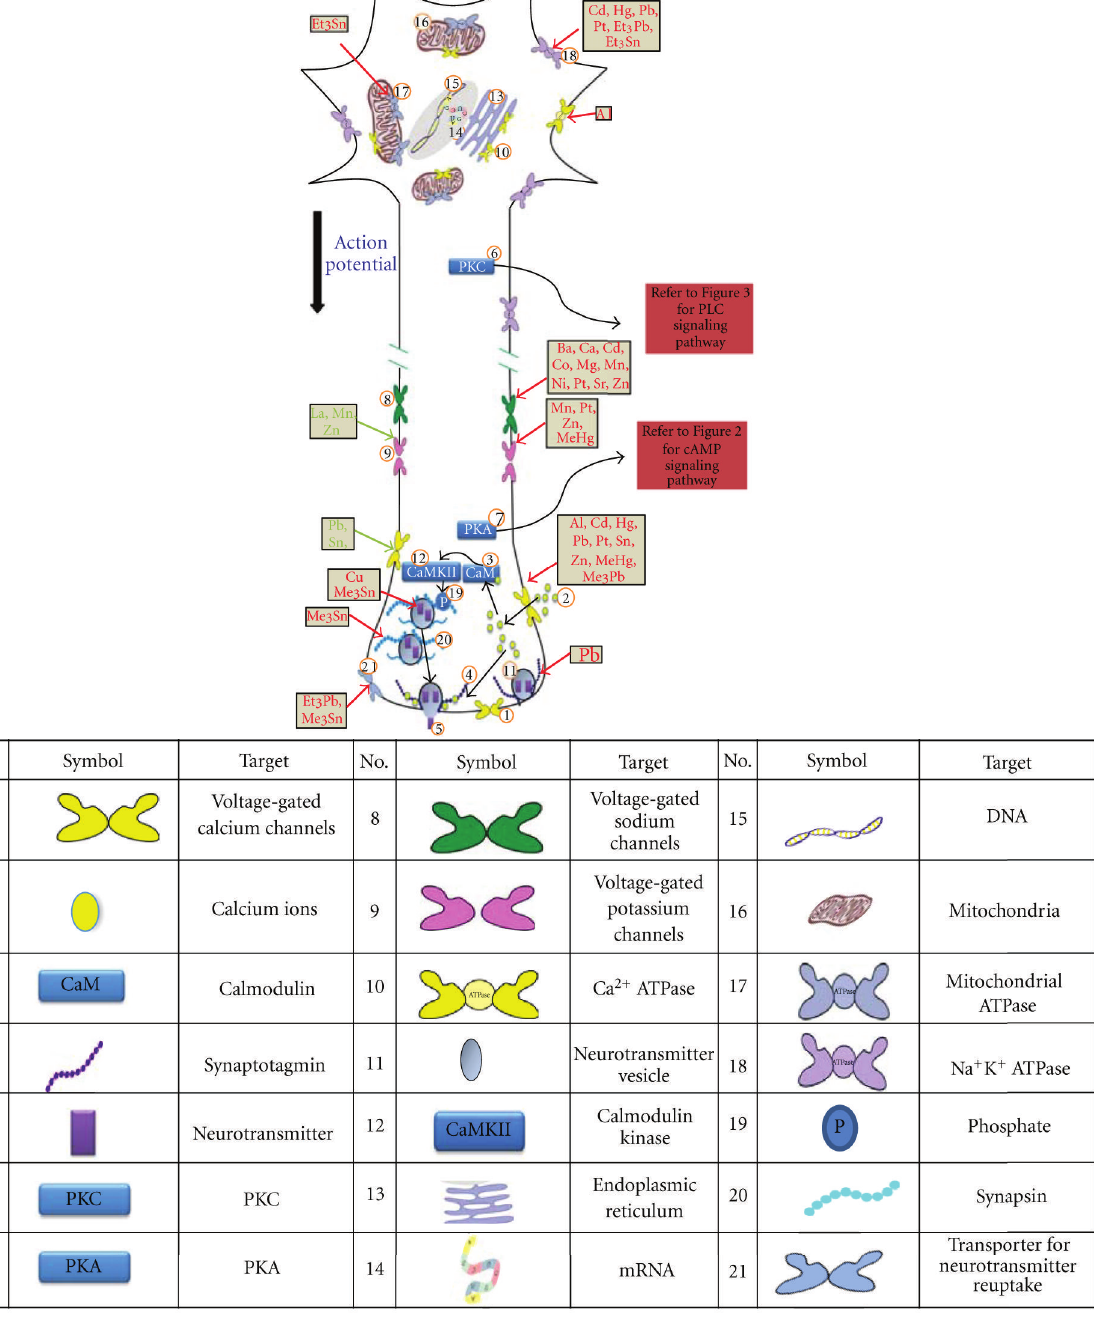
Figure 1: Presynaptic targets of neurotoxic metals. Events at the synapse from the arrival of the action potential which results in the membrane depolarization-induced opening of voltage-activated calcium channels and the entry of calcium which activates CaM, which activates CaM kinases and causes the phosphorylation of synaptic vesicle-associated proteins and an increase in readily releasable neurotransmitter vesicles. Calcium also binds synaptotagmin and causes exocytosis of neurotransmitter from the vesicles. Shown in boxes are the metals and the targets at which they act in the synaptic transduction pathway. A table at the end indicates the symbols and what they indicate. Green indicates activation or upregulation while red indicates inhibition or downregulation. Please refer to the section of Abbreviations and